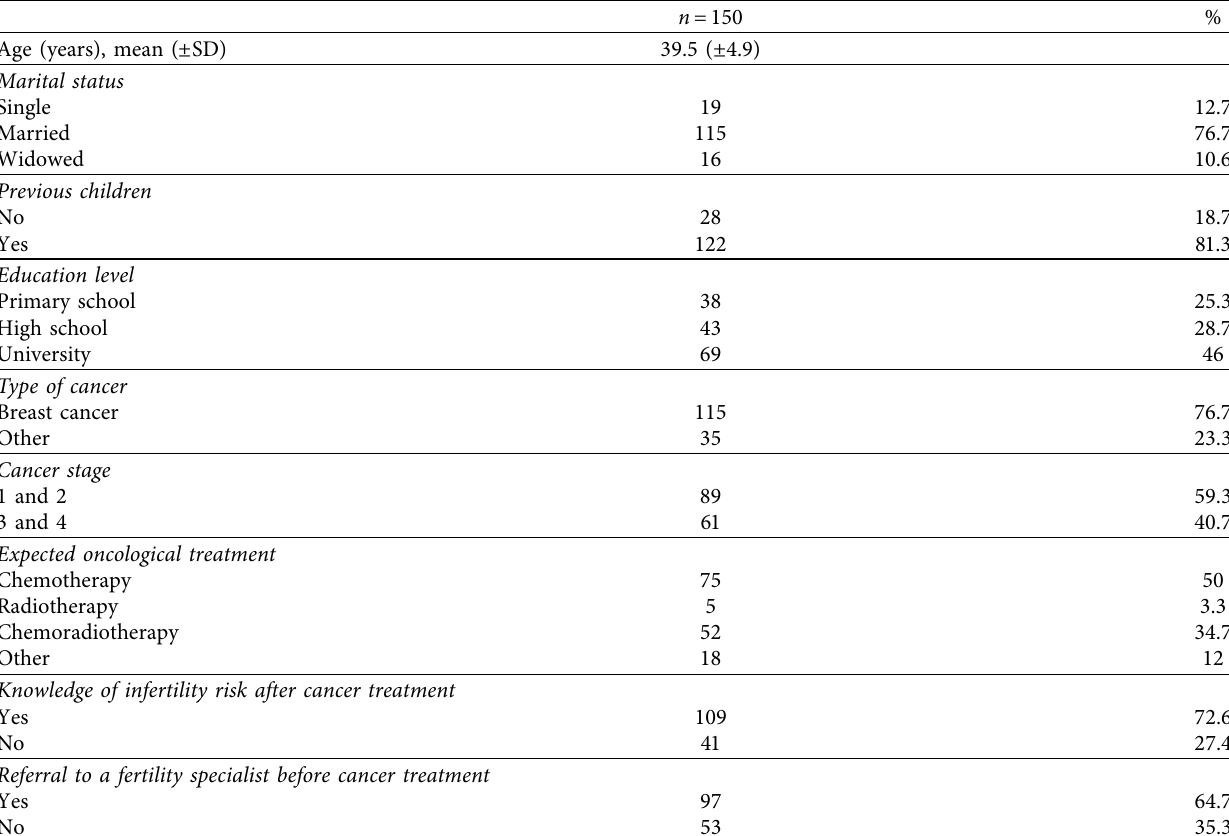
Table 1: Patient characteristics.